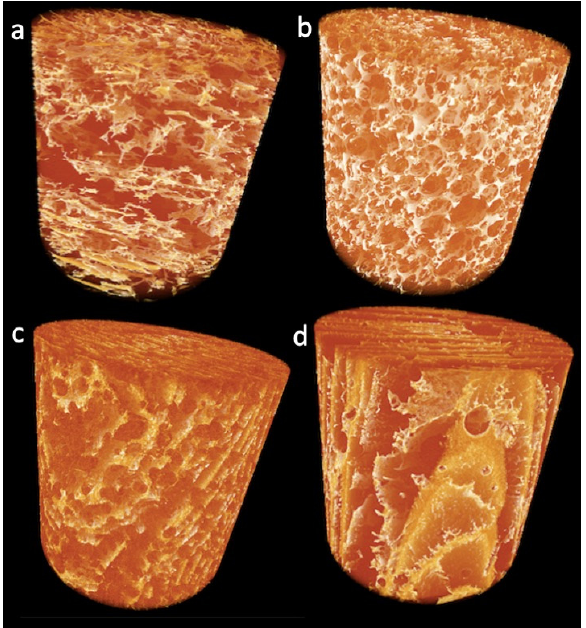
Figure 4. 3D tomographs of lupin foams. ( a ): LPI-0-0; ( b ): LPI-0-SB6; ( c ): LPI-Lec-SB6; ( d ): LPI-LA-SB6.